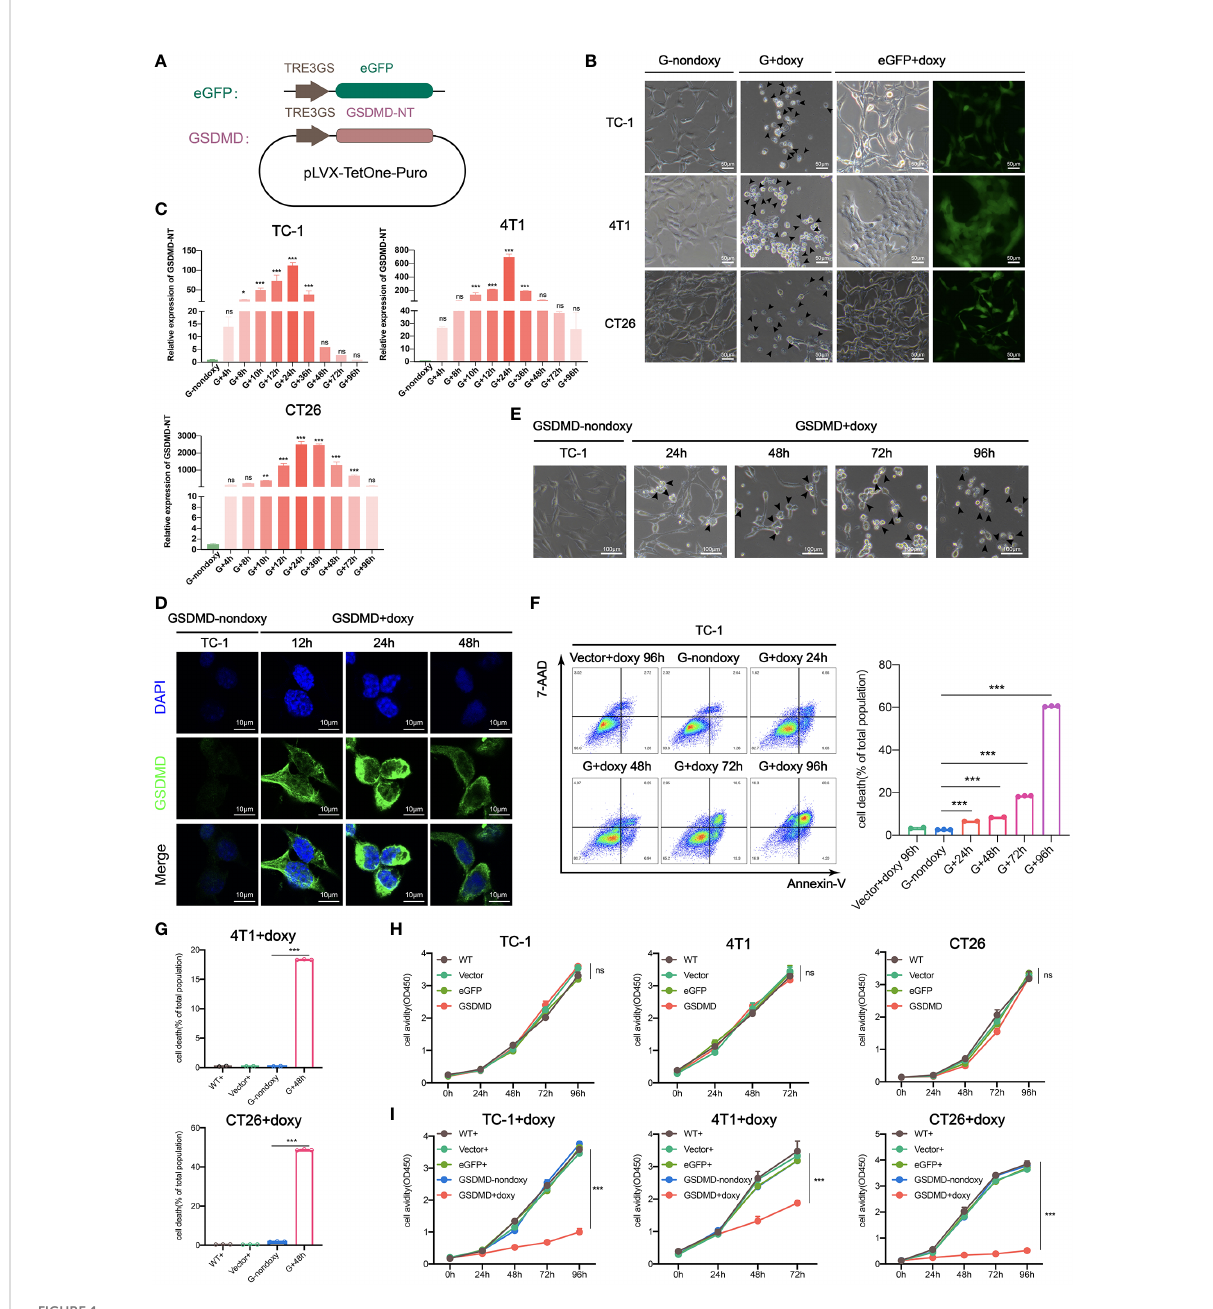
FIGURE 1 Inducible expression of genetically modi fi ed GSDMD-NT causes pyroptosis in TC-1/4T1/CT26 tumor cells. (A) Schematic presentation of the Tet- On-inducible GSDMD-NT or eGFP expression constructs. (B) Representative images of GSDMD-NT or eGFP expressing cells after 48 hours of incubation with doxy. Arrowheads indicate pyroptotic cells. Scale bar, 50 m m. GSDMD or G-nondoxy indicates GSDMD-NT gene-modi fi ed cells without doxy induction. (C) Histogram analysis of the dynamic expression of GSDMD-NT in TC-1/4T1/CT26 tumor cells measured by RT-qPCR (n=3). G+ indicates induction of GSDMD-NT gene-modi fi ed cells by doxy. (D) Immuno fl uorescent staining was performed after incubation with doxy for various durations in TC-1 cells. Blue: DAPI-stained nuclei, green: GSDMD-NT detected with FITC-labeled anti-GSDMD antibodies. Scale bar, 10 m m. (E) The classical pyroptosis-like cell morphological changes including swelling in doxy-induced GSDMD-NT-modi fi ed TC-1 cells. Scale bar, 100 m m. (F) Representative fl ow cytometry pseudocolor dotplots of 7-AAD- and Annexin V-stained GSDMD-NT expressing TC-1 cells after incubation with doxy (left), vector+doxy (representing represents vector-transfected cells induced with doxy) for 96 h as a homotype control, and G-nondoxy as a blank control. Histogram analysis of dynamic cell death in 7-AAD and Annexin V double-positive cells (right) (n=3). (G) Histogram analysis of fl ow cytometry results of 7-AAD and Annexin V double-positive 4T1 and CT26 cells at 48 hours after incubation with doxy (n=3). (H) Proliferation curve of TC-1/4T1/CT26 cells stably transfected with vector, eGFP, or GSDMD-NT and wild-type (WT) by CCK-8 assays (n=5). (I) The toxicity of doxy was detected by cell proliferation avidity curve. Doxy was added to vector+, eGFP+, GSDMD-NT+ and wild type (WT+) TC-1/4T1/ CT26 cells, and GSDMD-nondoxy was used as a control, “ + ” represents doxy induction (n=5). (C, F, G – I) Graph shows means ± SD; One-way ANOVA; * p value < 0.05, ** p value < 0.01, *** p value < 0.001, ns represents no signi fi